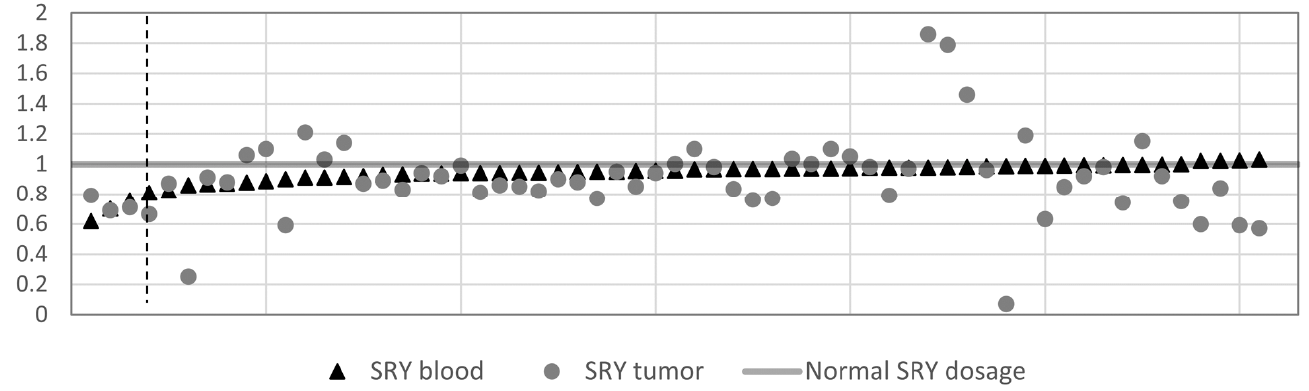
Figure 5. Comparison of SRY CN in the 61 matched blood and GBM samples. There is a large SRY CN divergence between both tissues, with most blood samples lacking any CN alterations. Thus, the CN aberrations can be considered tumor private. Dashed line separates 3 samples with SRY deletion (CN < 0.8) detected in both blood and tumor tissue.